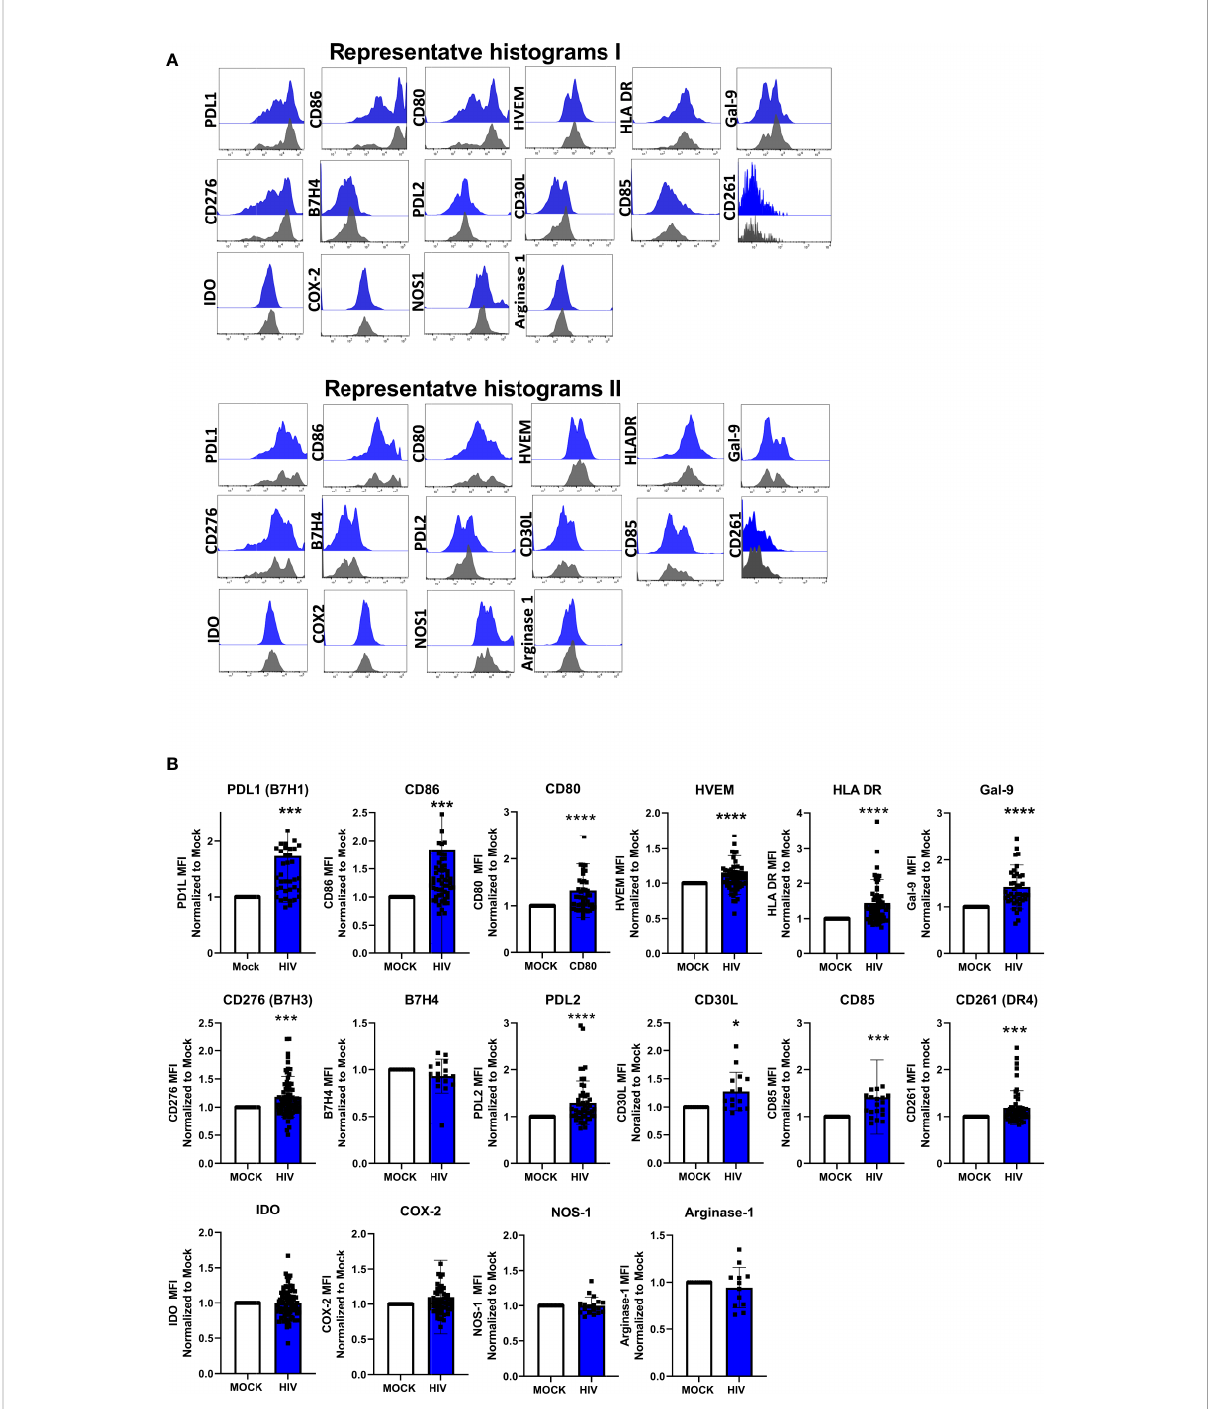
FIGURE 4 Presence of HIV in DC-T cells coculture give rise to DCs with upregulated protein expression of molecules associated with a tolerogenic phenotype. DC-T cell cocultures, unexposed or exposed to HIV were harvested after 8 days. DCs in the coculture were identi fi ed by expression of CD1c. DC expression-levels of PDL1, CD86, CD80, HVEM, HLA DR, Gal-9, CD276/B7H3, B7H4, PDL2, CD30L, CD85, CD261/DR4, IDO, COX- 2, NOS1, and arginase 1. Representative histograms of 2 donors show the expression of these markers on CD1c positive DCs (A) . Graphs of normalized MFI values of the markers on CD1c positive DCs (B) . The experiments (N=12-60) were normalized by setting each donor ’ s mock value to one and compared to the corresponding HIV value, and Wilcoxon test performed. Shown are min to max and all data points. * P <0.05, *** P <0.001, **** P